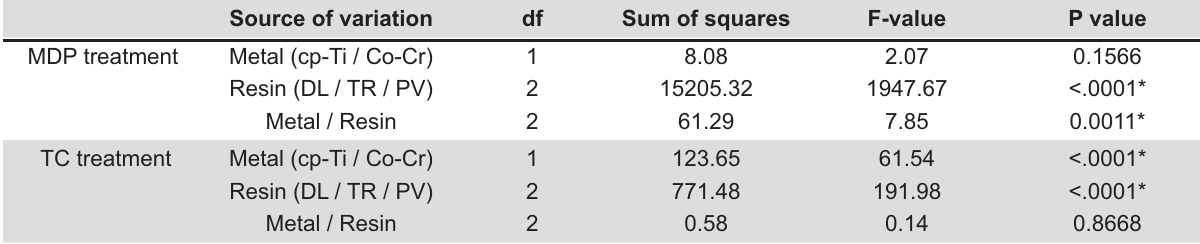
Unit: % Table 3- Results of two-way factorial